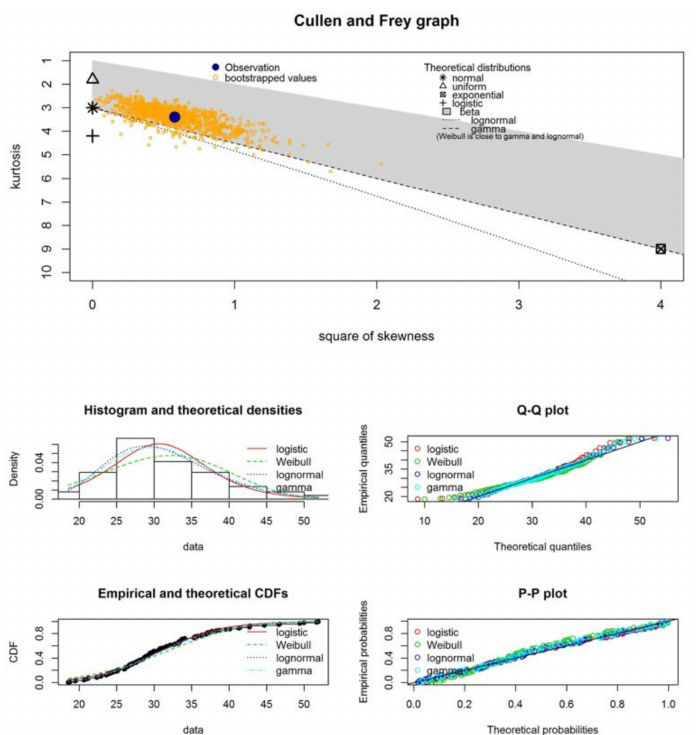
Figure A6. Statistical evaluation of nonwoven samples modified with carbon-based functional coating and graphene: ( Top ) Cullen and Frey graph, and ( Bottom ) Probability density plot, cumulative distribution function, Q–Q plot, and P–P